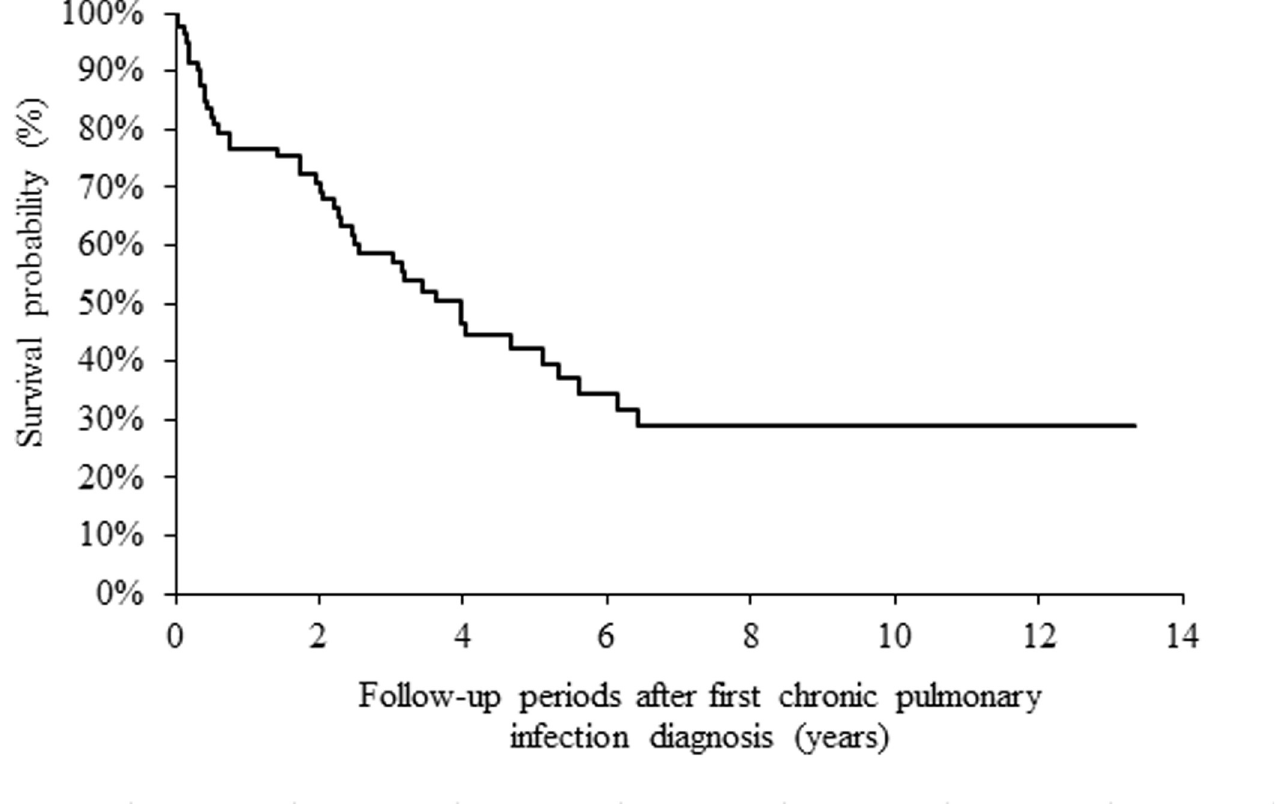
Fig 4. Kaplan-Meier survival curves of all-cause mortality after CPI (including groups B, C, and D).